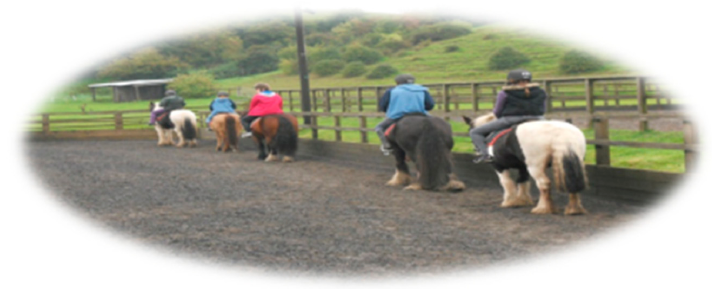
Figure 7. Human–horse rhythm, becoming “rhythmanalyst” (aware of one’s body rhythm) and in tune with one another.